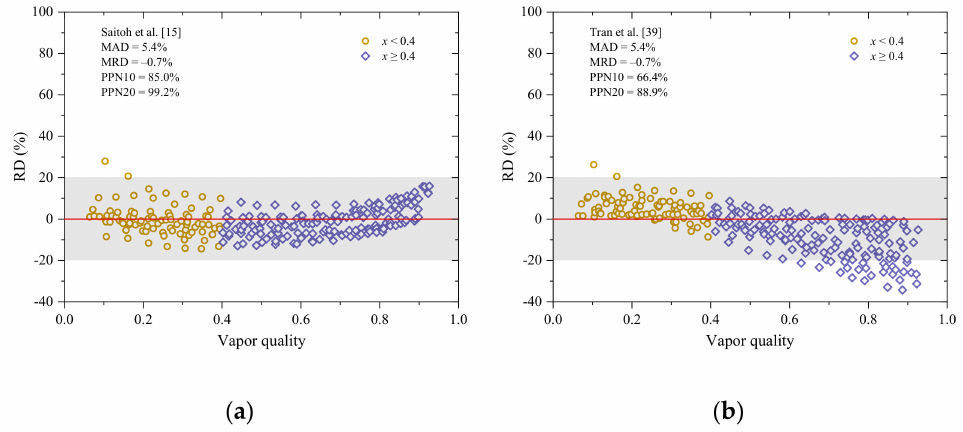
Figure 6. Error distributions of the heat transfer correlations: ( a ) Saitoh et al. [15]; ( b ) Tran et al. [39].